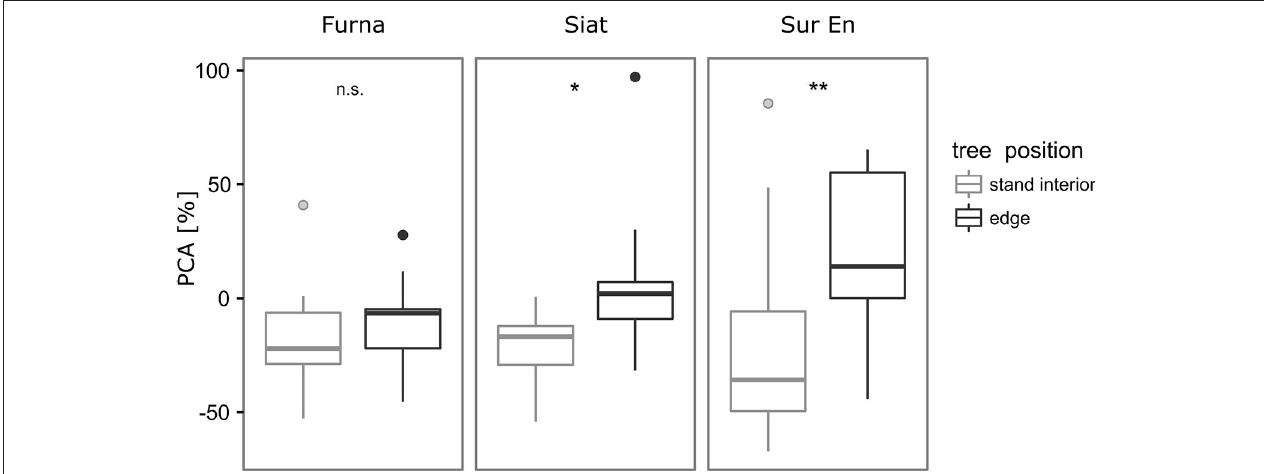
FIGURE 5 | Box plots of the percentage change in allometric slope α ’ i (PCA, %) of stand interior and edge trees after strip cutting. Wilcoxon rank-sum test was applied to test differences in PCA of the stand interior and edge trees within each site, significance levels as follows: * p ≤ 0.05, ** p < 0.01, n.s. (not significant, p > 0.10). Individual points represent